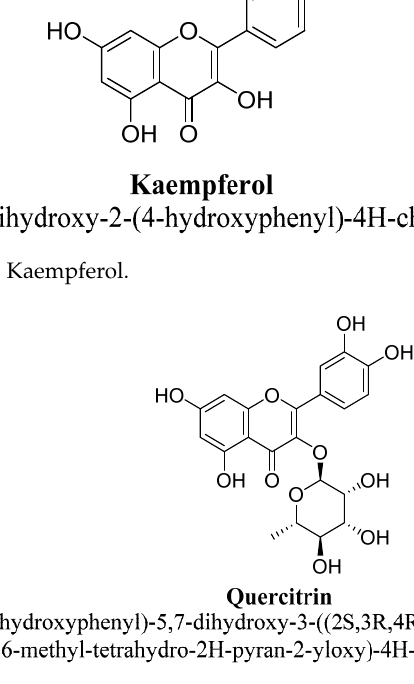
Figure 22. Quercitrin.